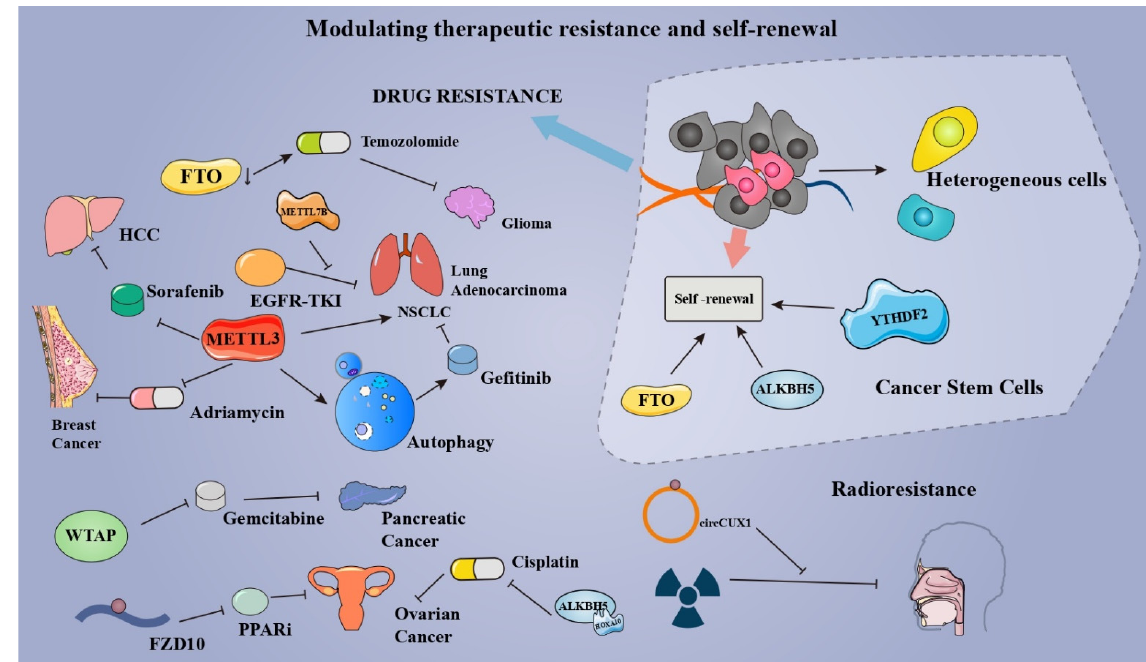
Figure 5. By modulating therapeutic resistance and self-renewal of cancers, methyladenosine modifications have the potential to mediate the efficacy of cancer therapy.